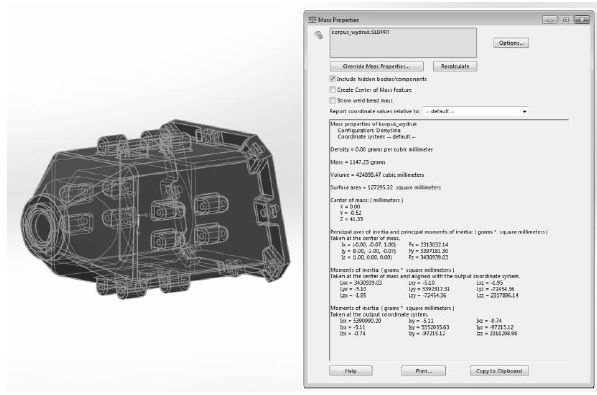
Fig. 6. Parameters obtained during the simulation Fig. 8. Determining parameters for the robot body Figure 6: Parameters obtained during the simulation. Figure 8: Determining parameters for the robot Simulations of liquid flow around the different robot configurations were performed at various pressures both for open water reservoir and various diameter pipe conditions. The tool shown in Fig. 8 was used to determine the necessary weight and volume parameters for all elements of an underwater inspection robot.